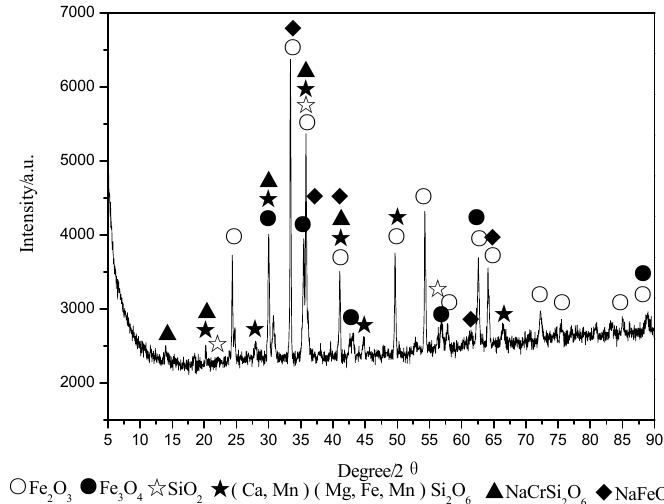
Figure 1. The XRD pattern of vanadium slag before roasting.